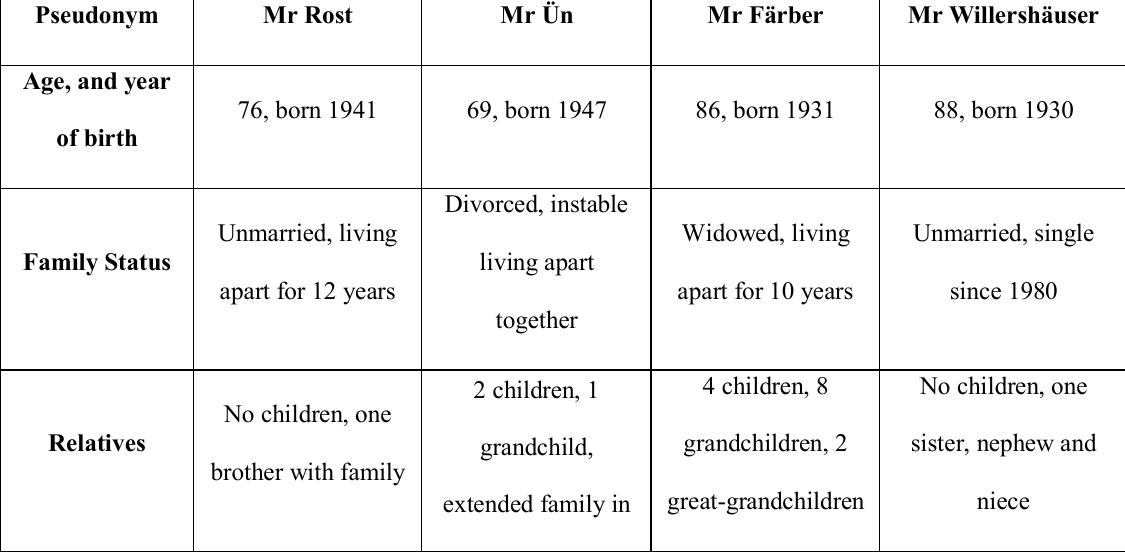
Table 2: Sample characteristics of the interviewed men